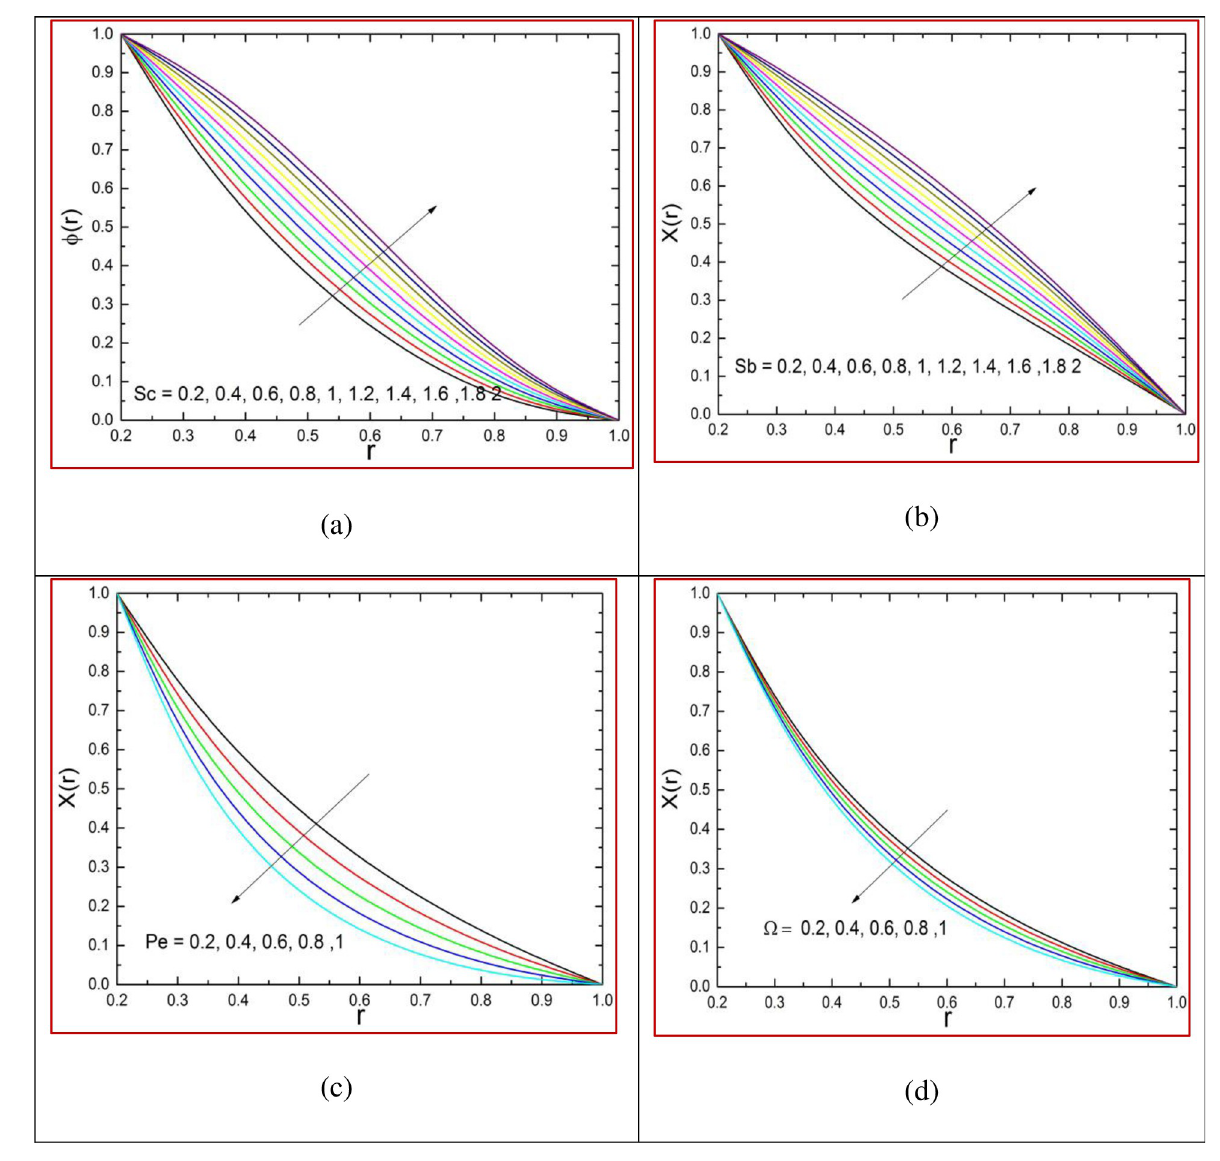
Fig 5. The impact of Sc , Pe and O on F ( r ) and X( r